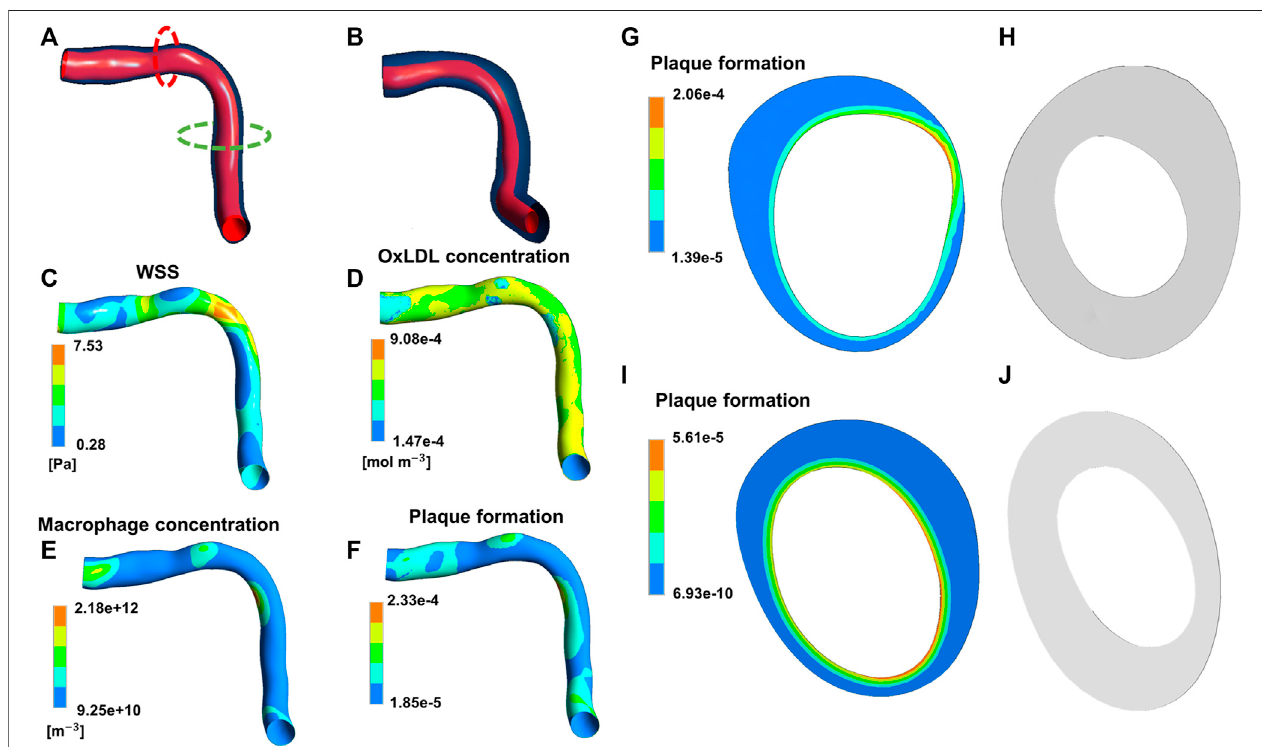
FIGURE 11 | Results of the continuum-based modeling framework of atherosclerosis by Pleouras et al. (2020). Panels (A,B) depict the artery geometry reconstructed at the initial condition and follow-up, respectively. The contour maps of wall shear stress (WSS) (C) , oxidized low-density lipoproteins (LDLs) (D) , macrophages (E) and plaque formation input (F) at theinitial condition areshown.Panels (G,H) refer tothe red dashed linein (A) with the initial inputof plaque formation (G) andthecomputedoutputcross-section (H) .Panels (I,J) refertothegreendashedlinein (A) withtheinitialinputofplaqueformation (I) andthecomputedoutput cross-section (J) . Adapted with permission from Pleouras et al. (2020)